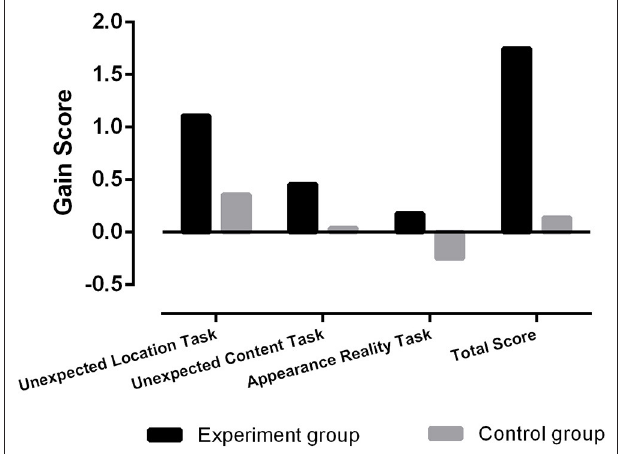
FIGURE 1 | Comparison of gain scores in the ToM tasks between the experiment and control